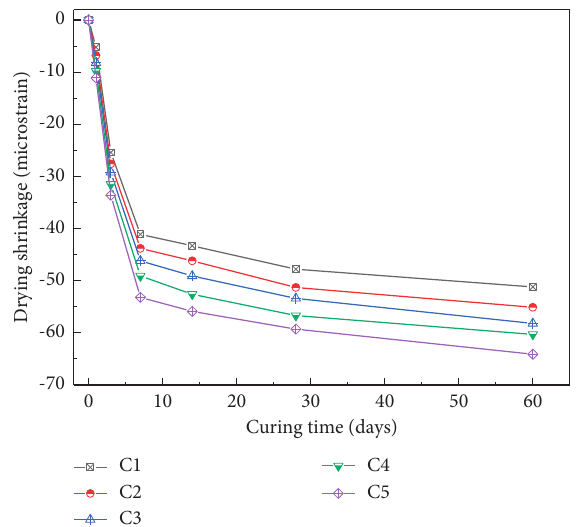
Figure 8: The drying shrinkage of the hardened sample with different additions of GGBS.